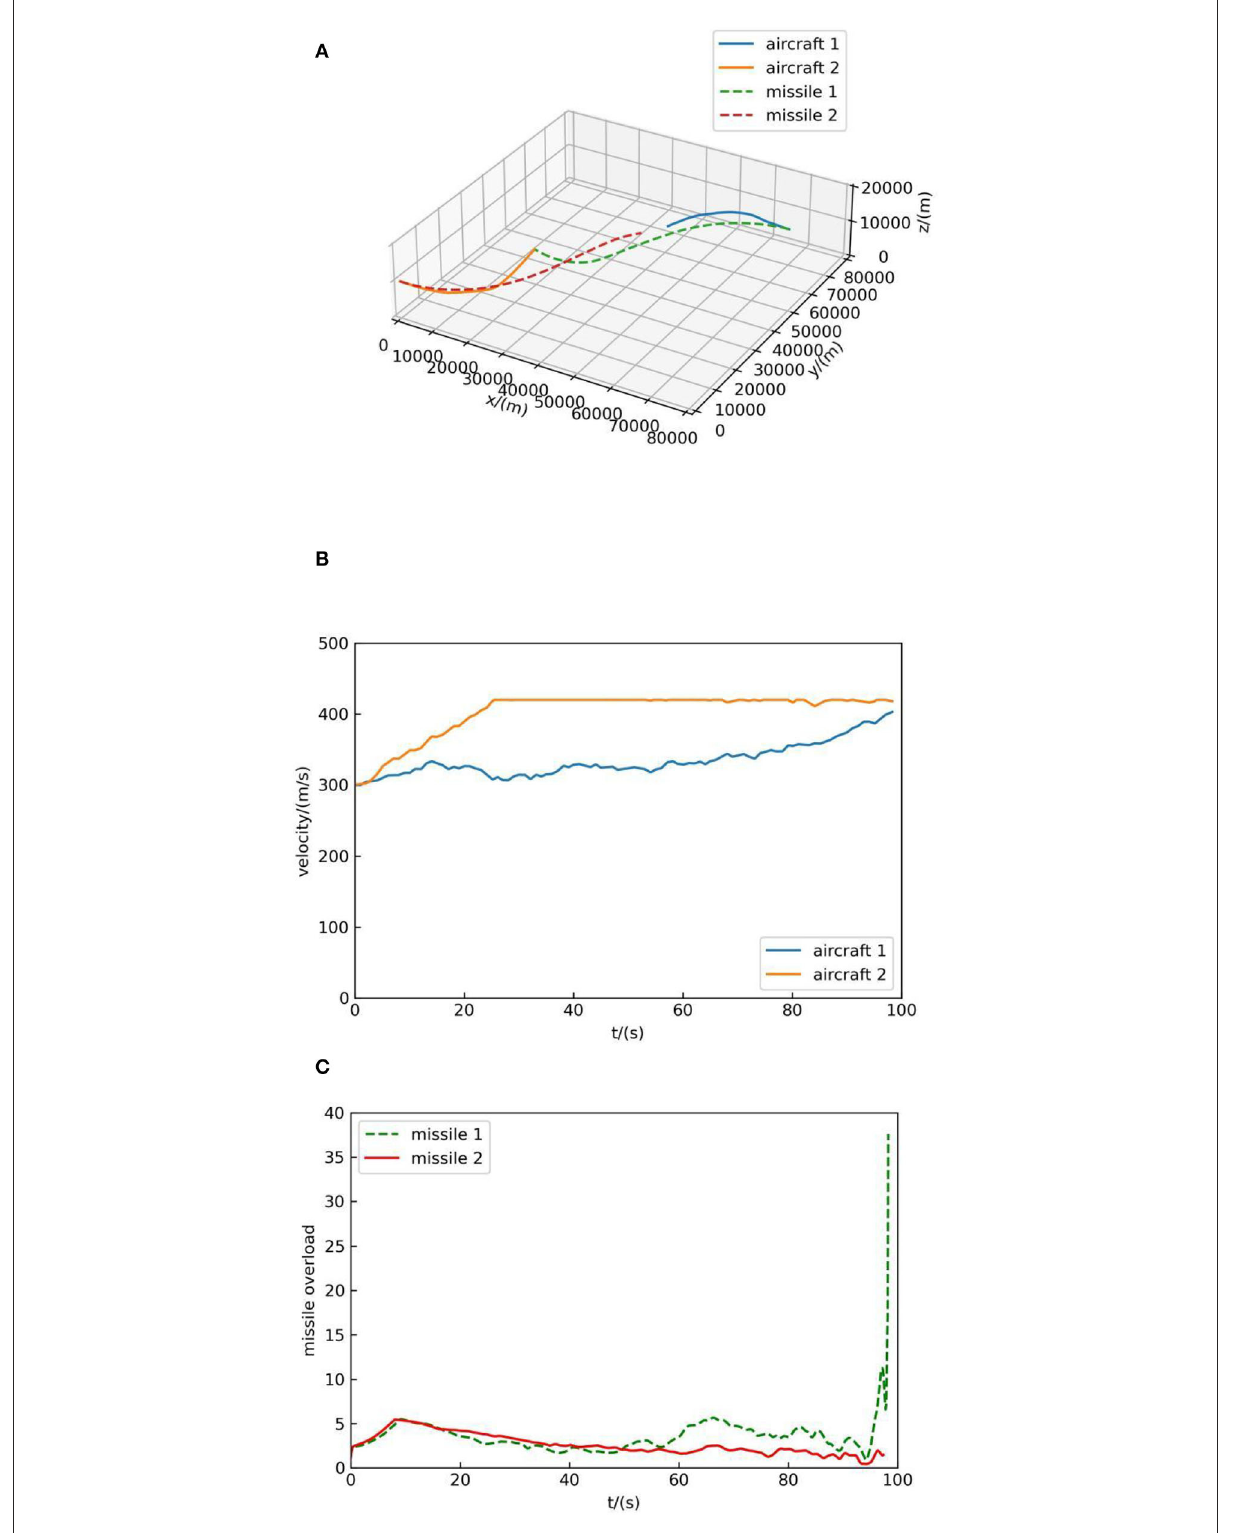
FIGURE8 Simulation result 2. (A) Air combat trajectory. (B) Velocity. (C) Missile